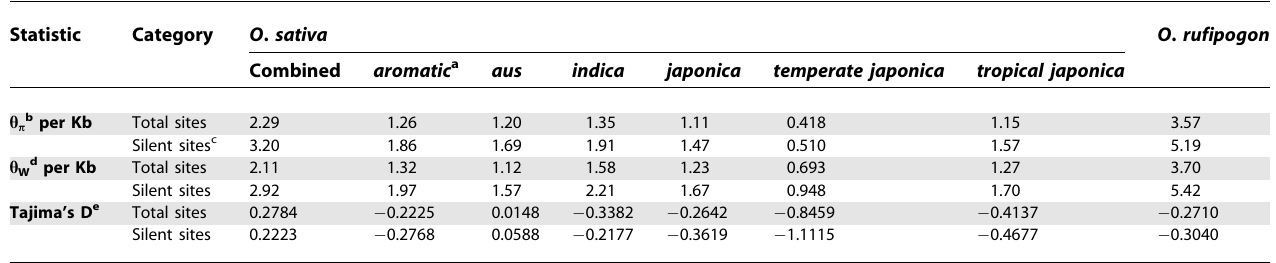
Table 1. Average Diversity Measures in Oryza spp. across 111 STS Regions